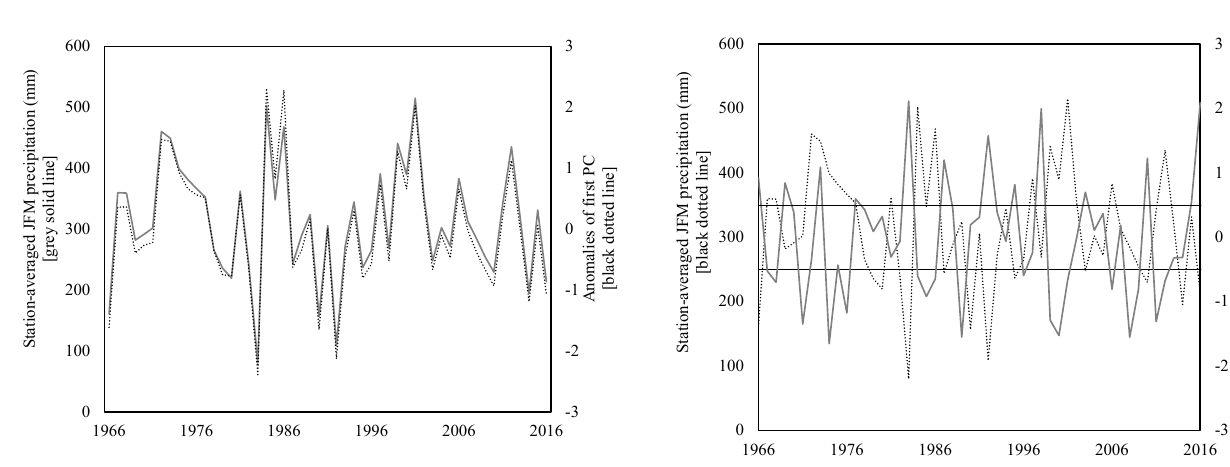
Figure 5. Station-averaged JFM precipitation and concurrent JFM Niño 3.4 SST anomalies ( r =− 0.57, p value = 0.000013). El Niño and La Niña thresholds marked with black solid line. During the period of record, 13 JFMs exceeded the El Niño threshold (0.5 ◦ C) and 18 JFMs the La Niña threshold ( − 0.5 ◦